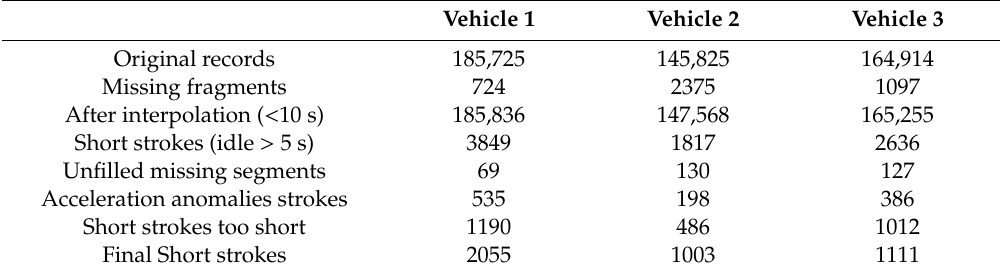
Table 1. Data analysis and statistic.